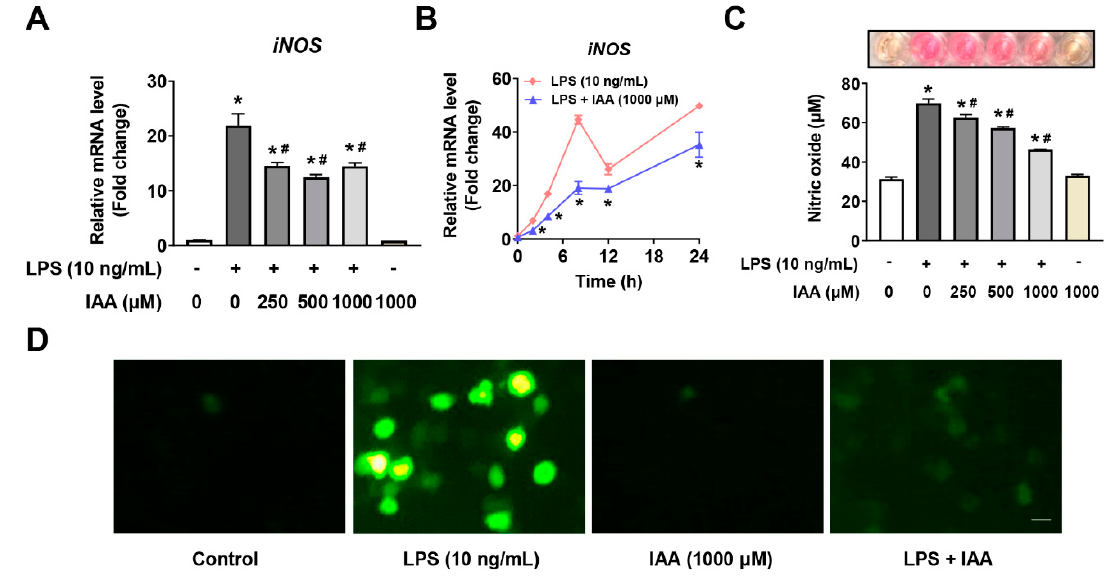
Figure 4. IAA inhibited the generation of NO and ROS induced by LPS in RAW264.7 cells. ( A ) Cells were incubated with various concentrations of IAA followed by LPS (10 ng/mL) for 8 h in the absence or presence IAA for 8 h, after which iNOS mRNA was determined by RT-qPCR. β -actin was used as the reference gene. Results are shown as mean ± SEM. n = 3. * p < 0.05 versus control group; # p < 0.05 versus LPS group. ( B ) Time-dependent effect of LPS or LPS + IAA on the expression of iNOS mRNA. Data are shown as mean ± SEM. n = 3. * p < 0.05 versus LPS group. Cells pre-incubated with indicated concentrations of IAA for 12 h prior to an additional 16 h exposure to LPS, after which NO content ( C ) in culture medium and intracellular ROS production ( D ) were evaluated as described in Materials and Methods. Results presents mean ± SEM. n = 3. * p < 0.05 versus control; # p < 0.05 versus LPS group. Scale bar represents 10 µm. iNOS, inducible nitric oxide synthase; NO, nitric oxide; ROS, reactive oxidative species; IAA, indole-3-acetic acid; LPS, lipopolysaccharide.